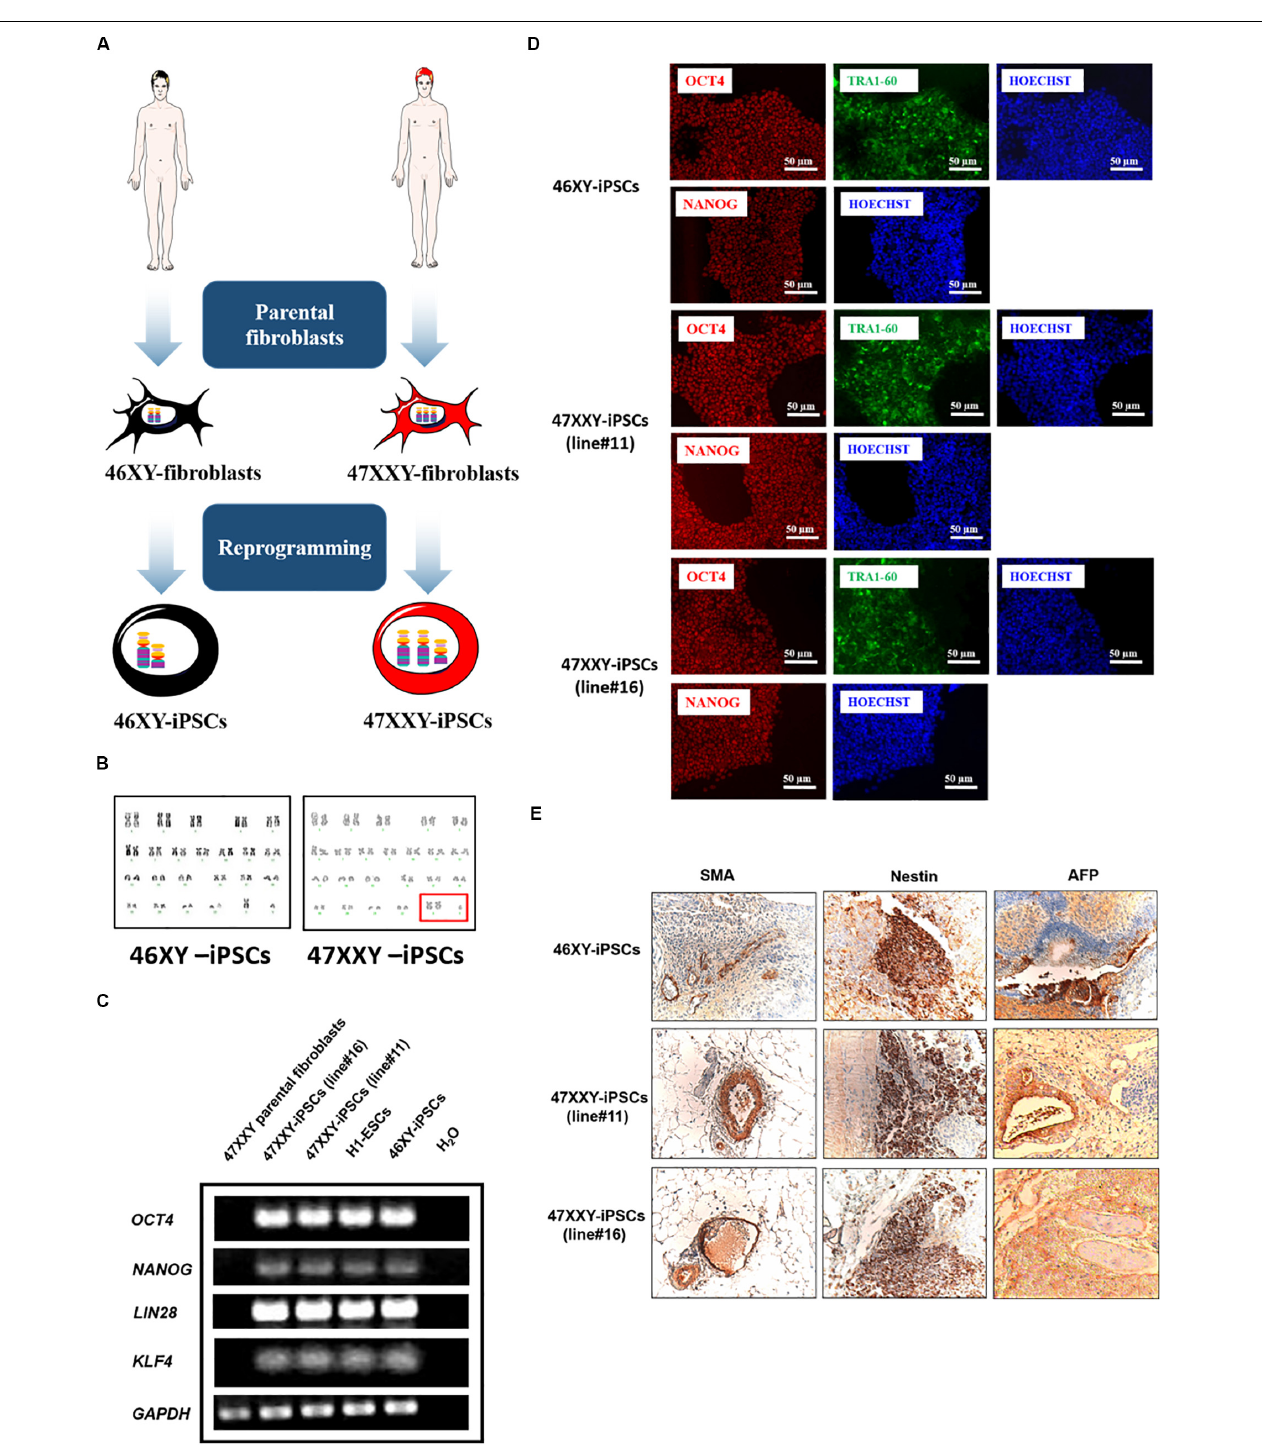
FIGURE 1 | 46XX-iPSCs and 47XXY-iPSCs exhibit markers of pluripotency. (A) Schematic representation for the reprogramming of 46XY and 47XXY parental fibroblasts into 46XY-iPSCs and 47XXY-iPSCs using OCT4 , SOX2 , KLF4 , and c-MYC genes (B) Karyotypes of 46XY-iPSCs and 47XXY-iPSCs are 46, XY and 47, XXY, respectively. (C) RT-PCR of pluripotency-related genes NANOG , OCT4 , KLF4 , and LIN28 in 46XY-iPSCs and 47XXY-iPSCs. The human embryonic stem cell line H1 (H1-ESCs) and the 47XXY parental fibroblasts were used as positive and negative controls for OCT4 , NANOG , KLF4 , and LIN28 expression, respectively. (D) Immunofluorescence staining of 46XY-iPSC and 47XXY-iPSC lines for the pluripotency markers NANOG, OCT4 and TRA1-60. (E) Immunohistochemistry analysis of teratoma sections generated after intramuscular injection of 46XY-iPSC and 47XXY-iPSC lines into SCID mice. These teratomas expressed α -SMA (mesoderm), AFP (endoderm) and β 3-tubulin (ectoderm).